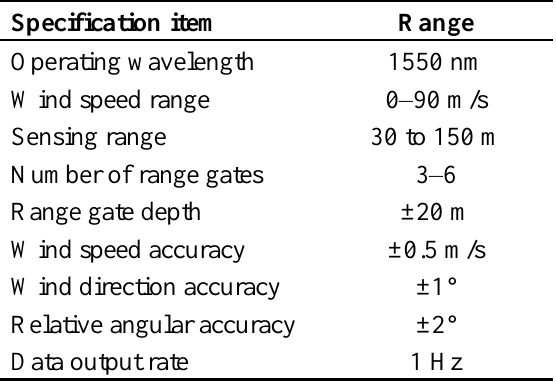
Table 1. Specifications of the Lidar system